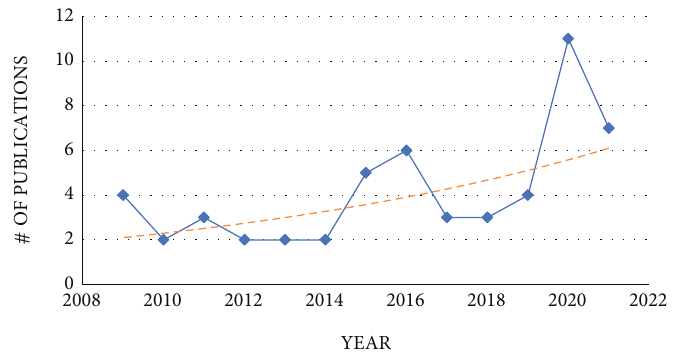
Figure 2: Publications per